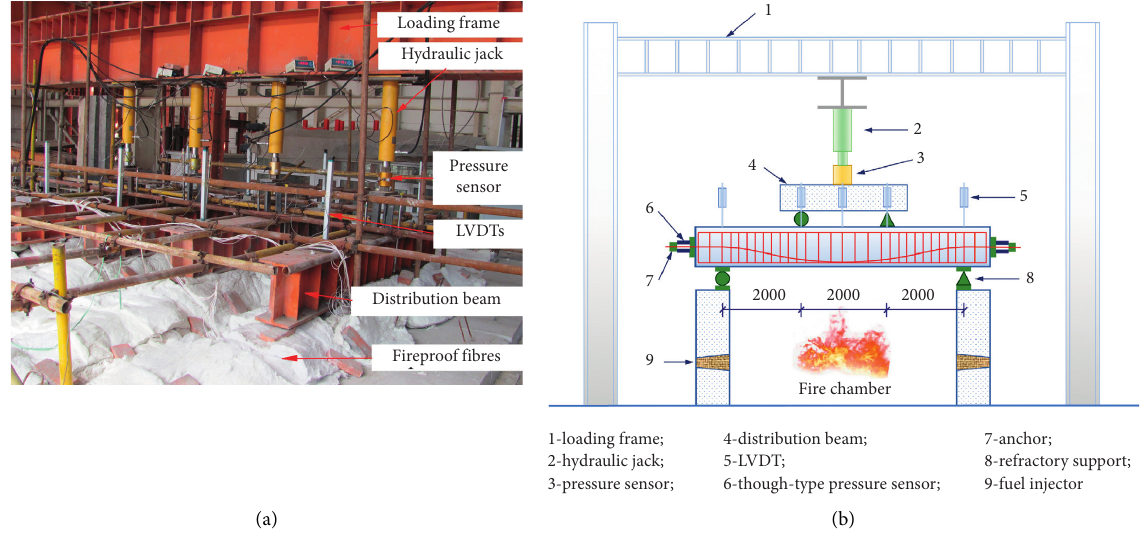
Figure 2: Fire test setup. (a) Lab view of test setup. (b) Test setup sketch.